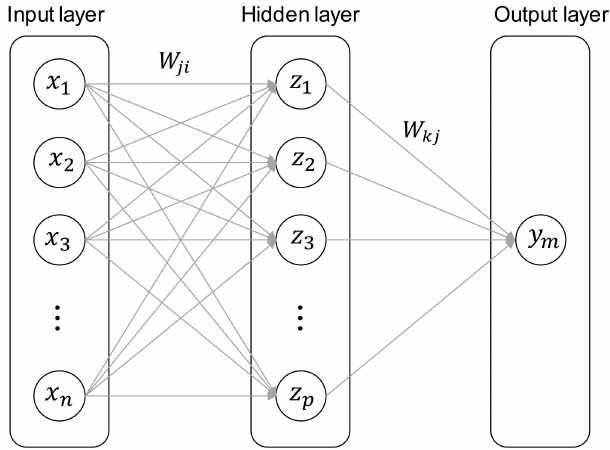
Figure 1. The basic structure of the Artificial Neural Network (ANN) model (input, hidden, and output